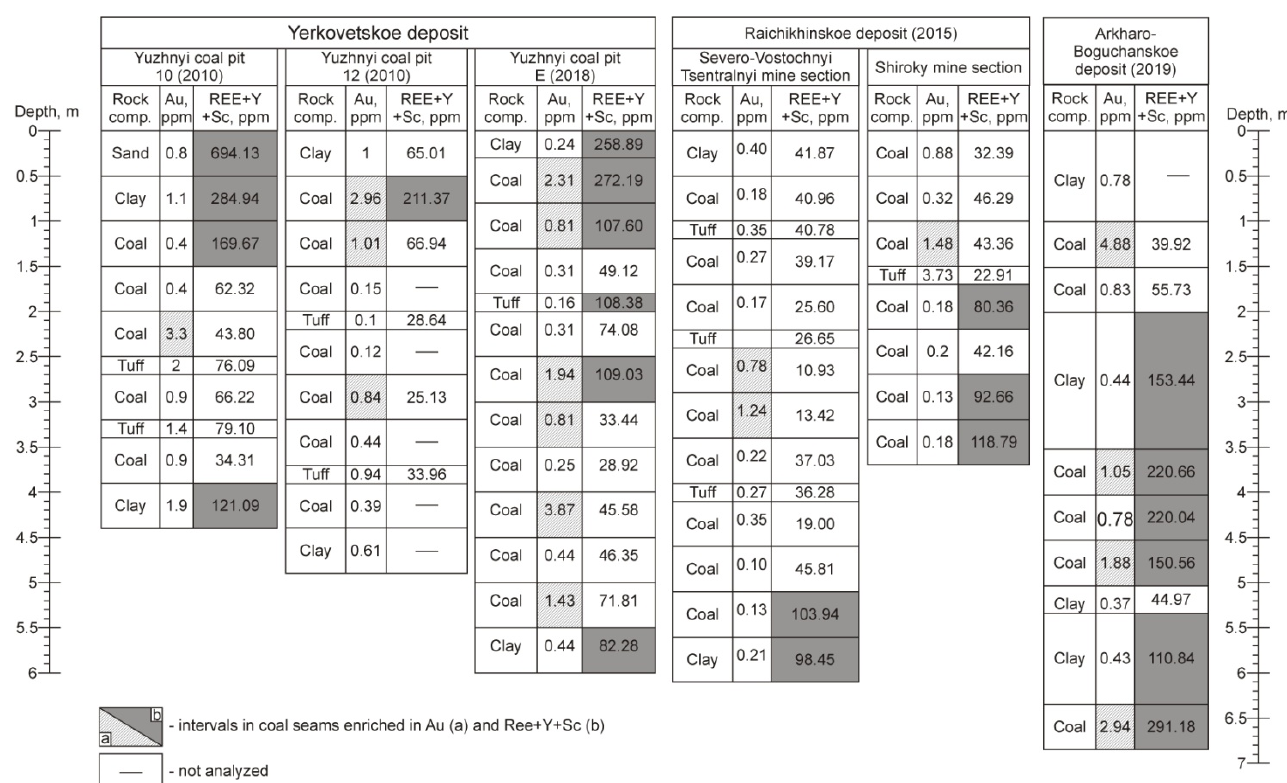
Figure 5. Distribution of Au and REE + Y + Sc in the Paleocene coals of the Yerkovetskoye, Raichikhinskoye, and Arkharo–Boguchanskoye coal deposits.